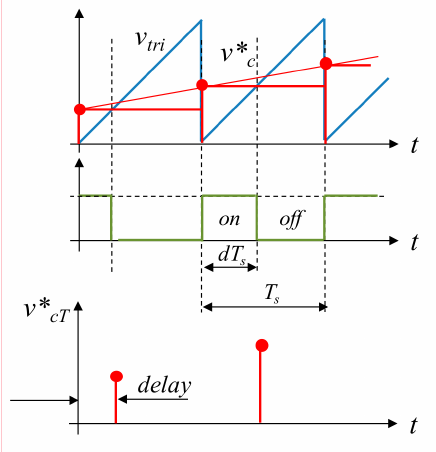
Figure 4. PWM modulator with uniform